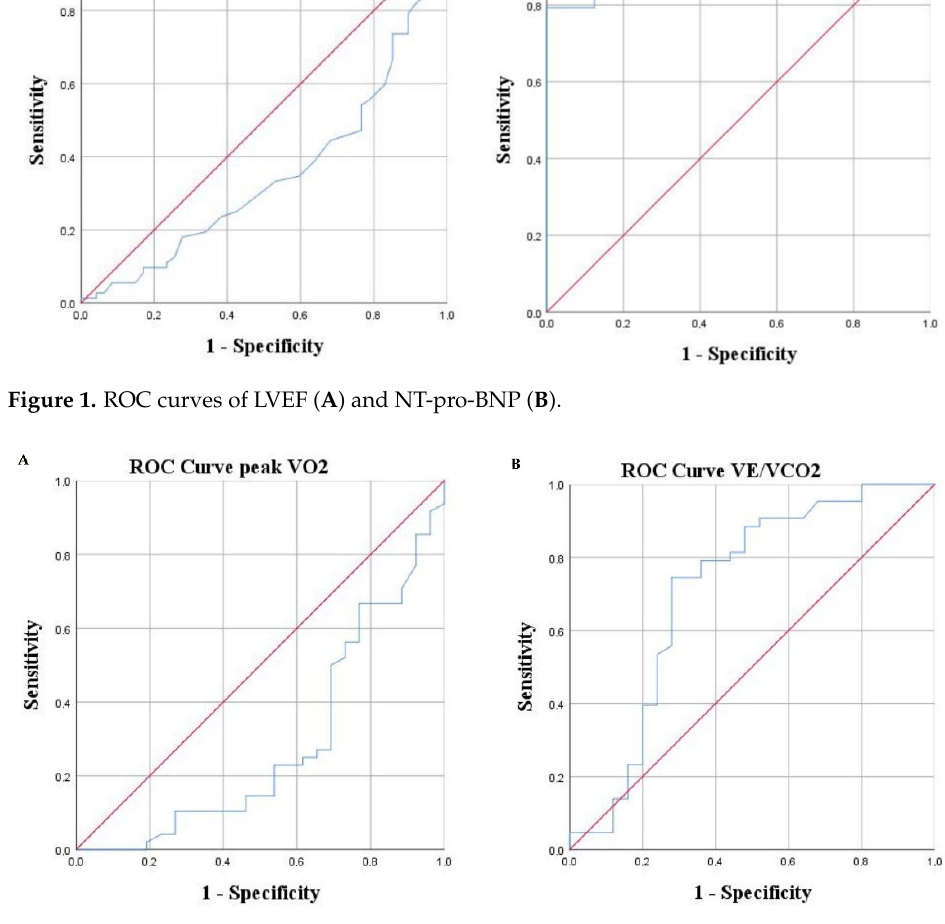
Figure 2. ROC curves of CPET parameters: V0 2 peak ( A ), VE/VCO 2 ( B ).